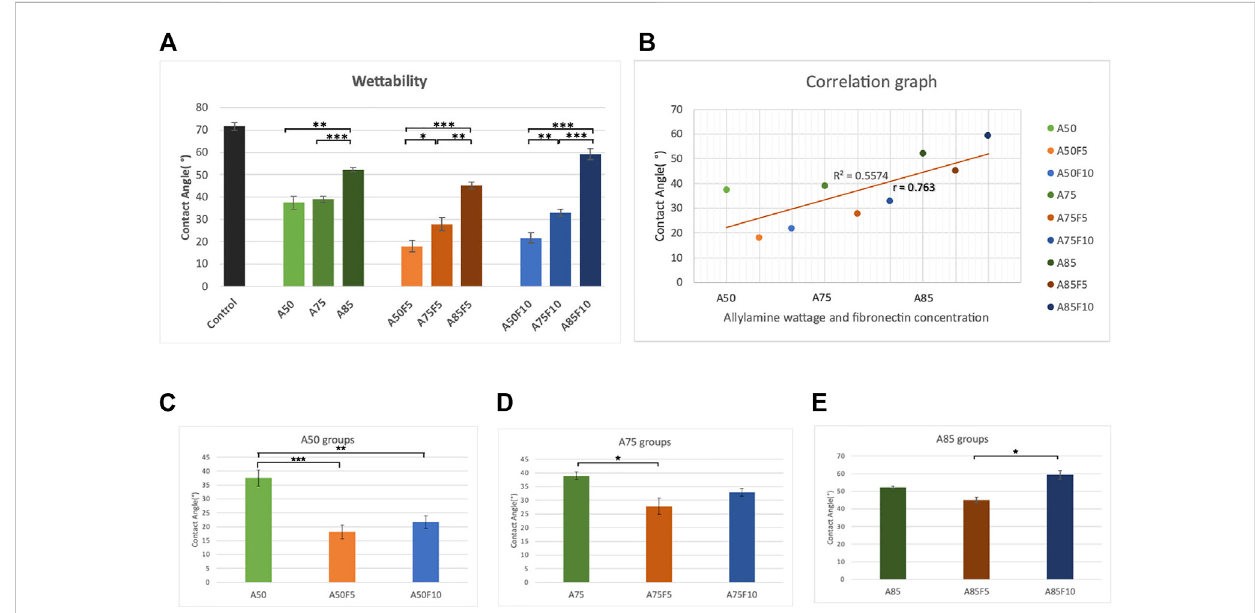
FIGURE 7 Surface wettability data demonstrating (A) better hydrophilicity in fi bronectin grafted groups (B) strong correlation coef fi cient between contact angle and concentration of allylamine and fi bronectin, surface wettability data of (C) control and A50 group (D) control and A75 group (E) control and A85